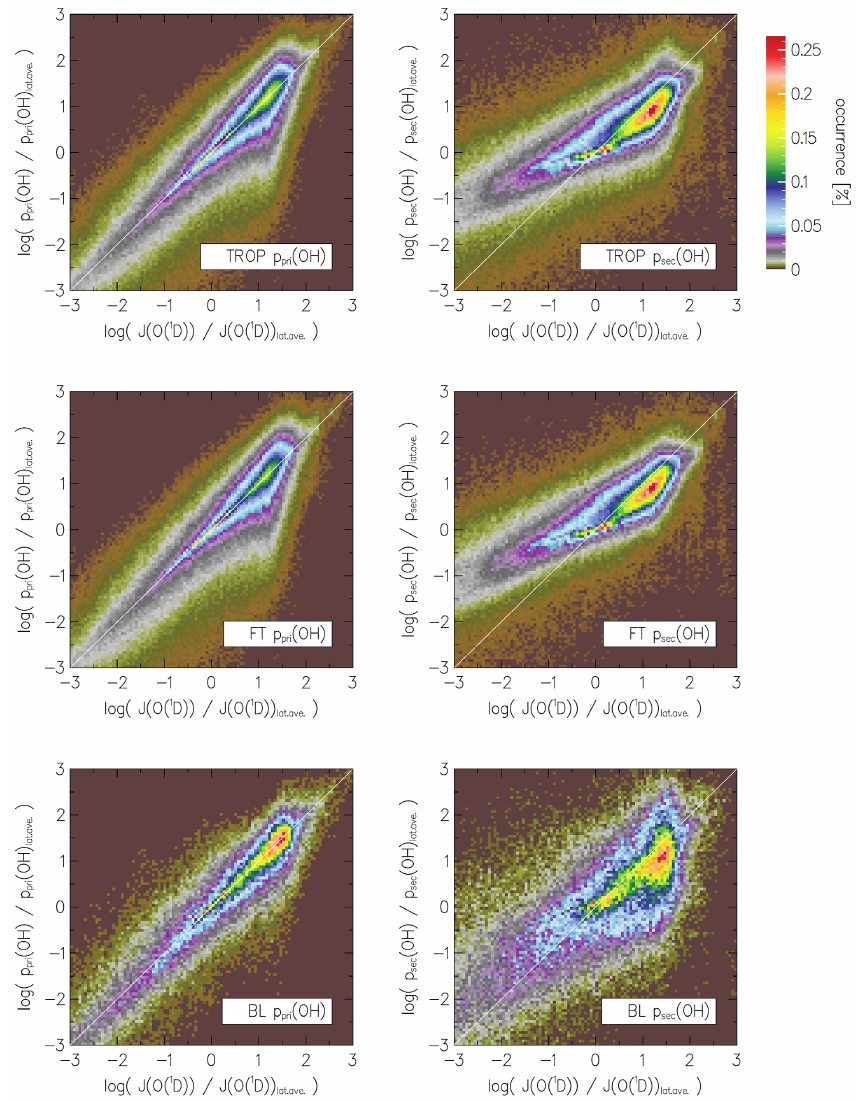
Figure 8. Correlation diagrams, showing P and S on the y axes as a function of the photodissociation rate of O 3 by Reaction (R1), J (O 1 D), on the x axes. Please notice the log–log scale. P is shown in the left panels and S in the right panels, in the troposphere (top), FT (middle) and BL